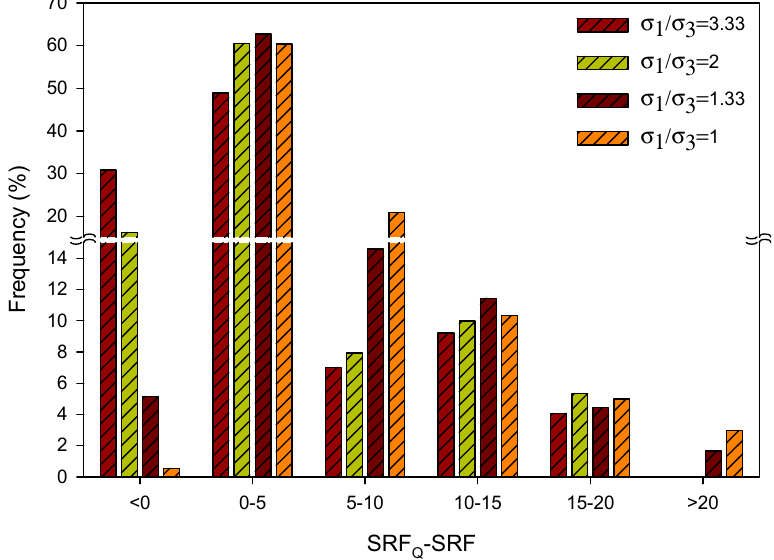
Figure 5. Difference in back-calculated stress reduction factor ( SRF Q ) with calculated SRF through Equation (4).